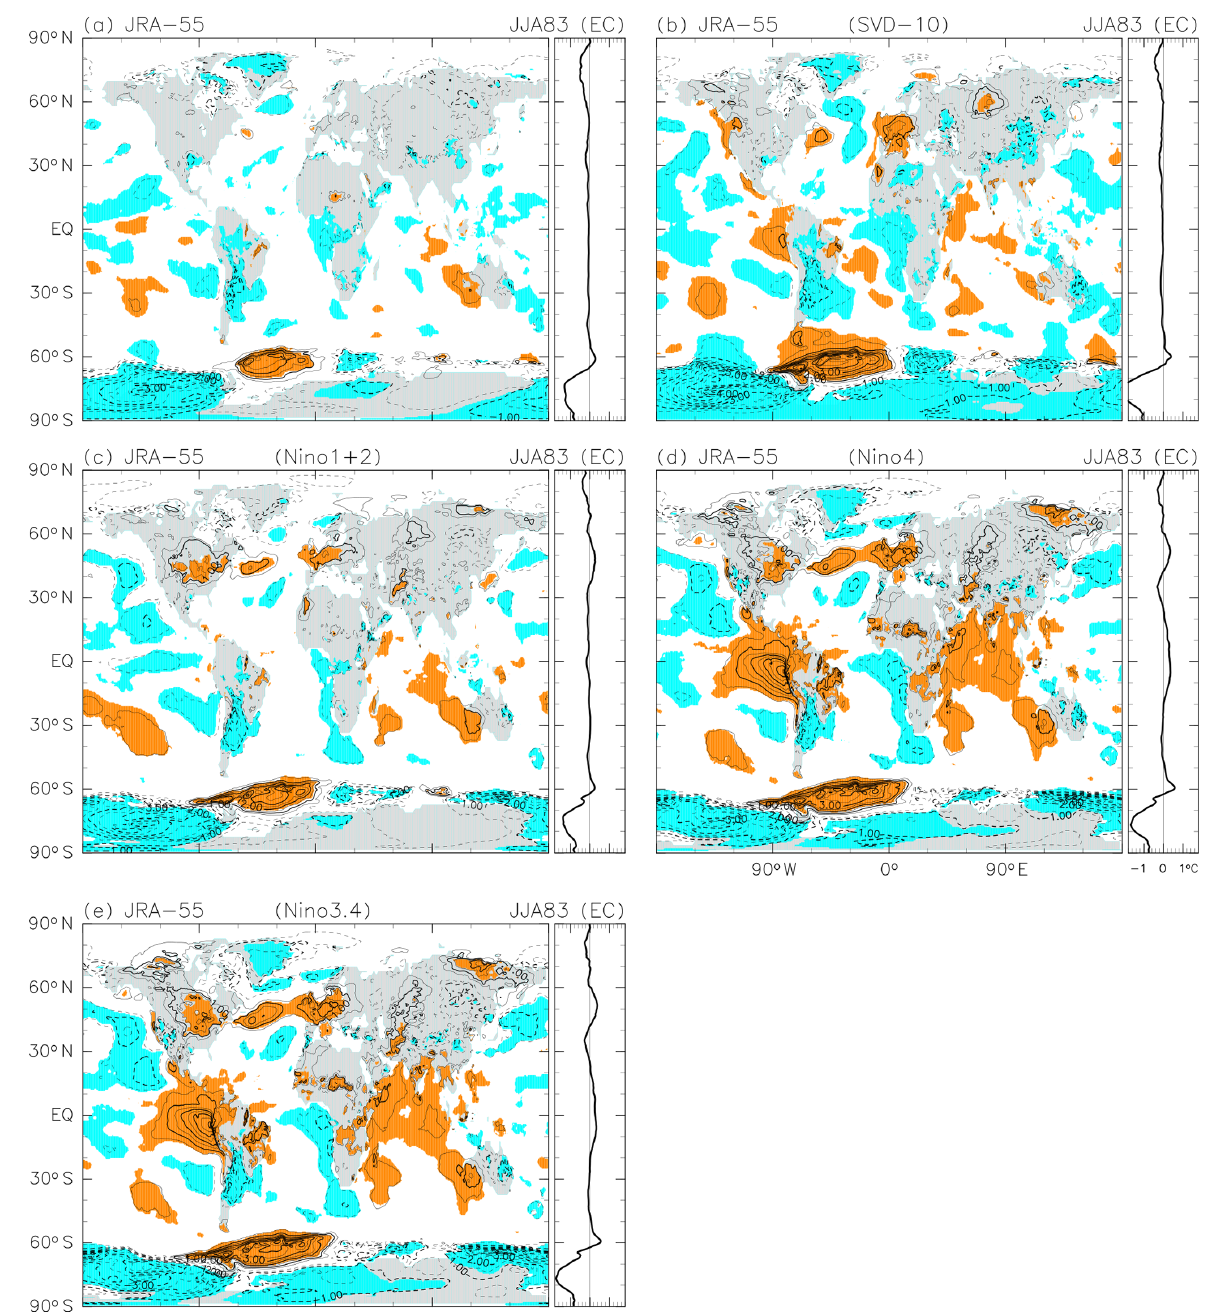
Figure A2. As for Fig. A1, but for the JJA 1983 anomalies following the El Chichón eruption in April 1982. The contour interval is 0.5K, without 0.0K lines. Coloured shading denotes anomalies that are positive (orange) or negative (blue) with magnitudes exceeding 1 SD of the 3-month mean R(t) at that